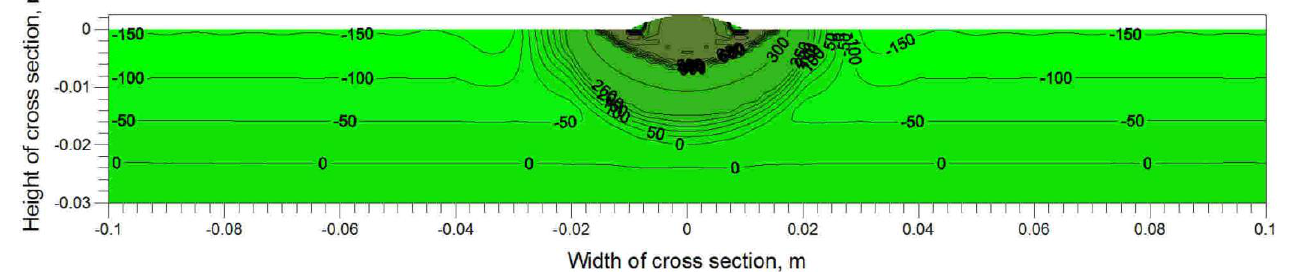
Figure 21 . Residual normal stress distribution in the cross section of plate